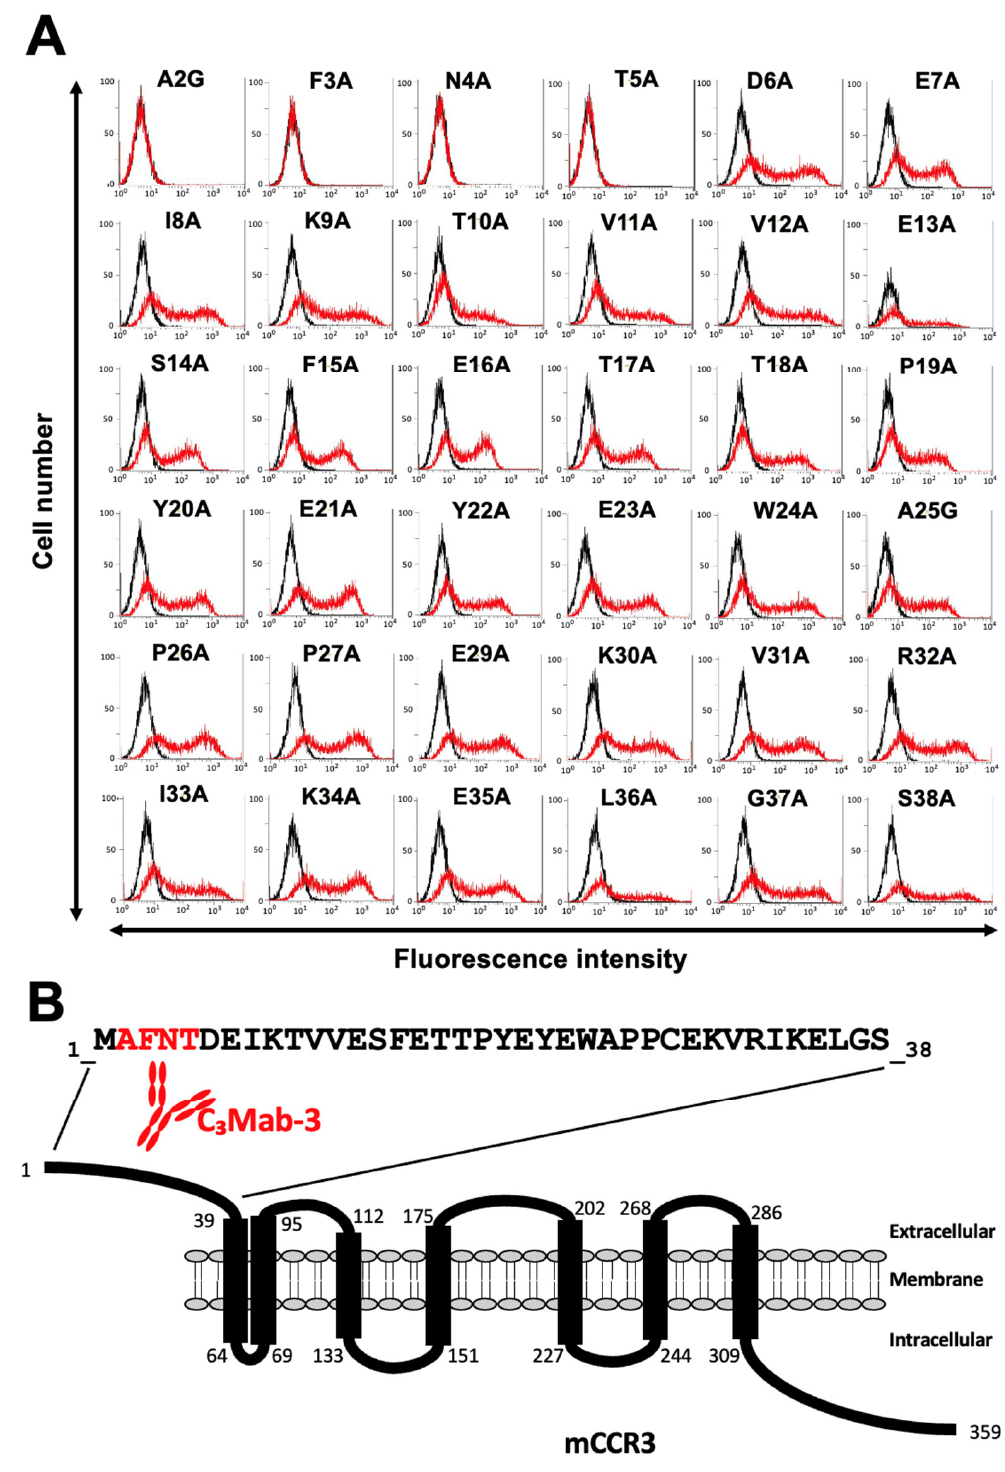
Figure 3. Determination of the C 3 Mab-3 epitope using flow cytometry and alanine scanning. ( A ) C 3 Mab-3 (1 μg/mL) was treated with CHO-K1 cells that transiently expressed mutant proteins for 30 min at 4 °C, followed by the addition of Alexa 488-conjugated anti-rat IgG. Red lines show the cells with C 3 Mab-3 treatment, and black lines show cells without Ab treatment as a negative control. ( B ) The C 3 Mab-3 epitope for mCCR3 involves Ala2, Phe3, Asn4, and Thr5 of mCCR3.